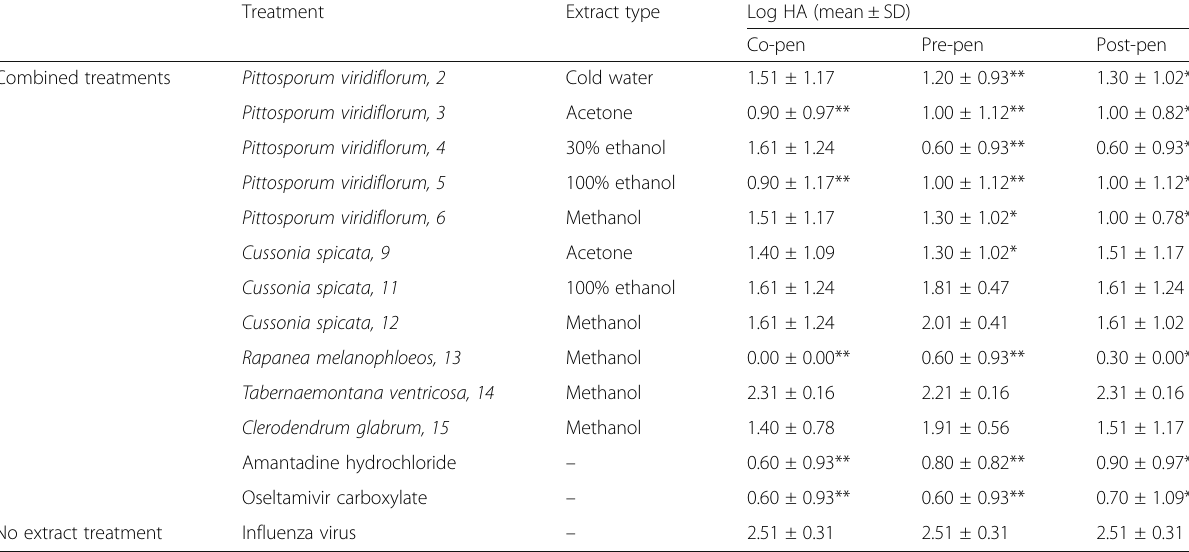
Table 3 Log 10 HA titer from HA assay in combined treatments with virus compared to virus control group Treatment Combined